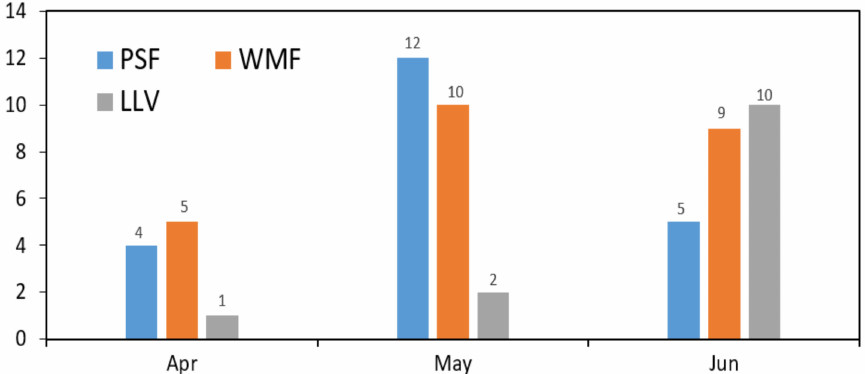
Figure 3. Monthly number distribution of the three major types (i.e., PSF, WMF, and LLV) of the 58 WSHR events over South China during the pre-summer months of